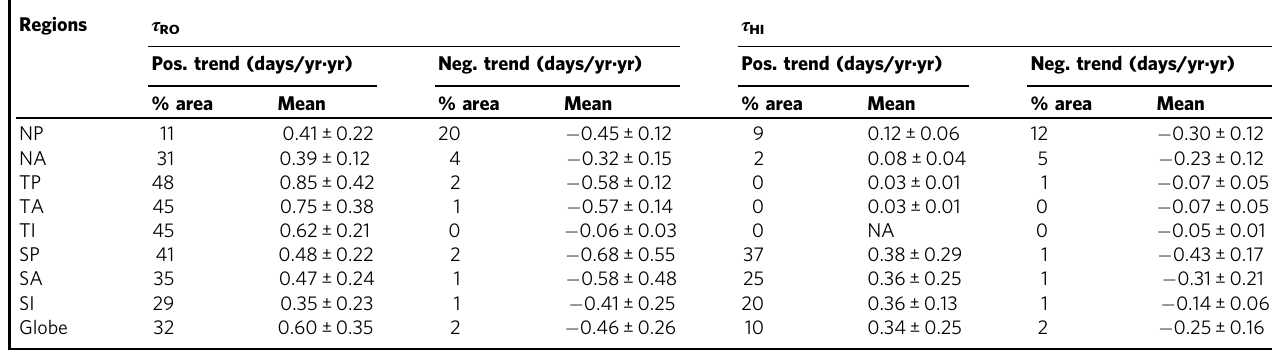
Table 6 Ensemble mean trends (days per year·year) and percent area experiencing robust signals of change in number of rough wave days ( τ RO ) and high wave days ( τ HI